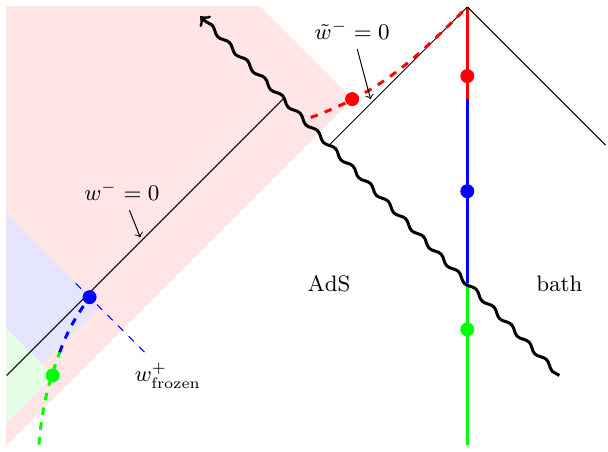
Figure 6 . A schematic plot of the 3 possible island saddle points corresponding to par ticular boundary points with the QES shown as blobs and the islands shown as the shaded regions. The boundary regions are coloured according to which type of QES has the minimum entropy and the motion of the QES’s are shown as the dotted lines. The green blob lies on the same Schwarzschild Cauchy slice as its boundary point, whereas the blue and the red lag behind. The null coordinate w + of the blue QES becomes frozen at roughly a scrambling time before t 0 . For large enough shockwave energy, the red QES lies behind the shifted horizon as shown